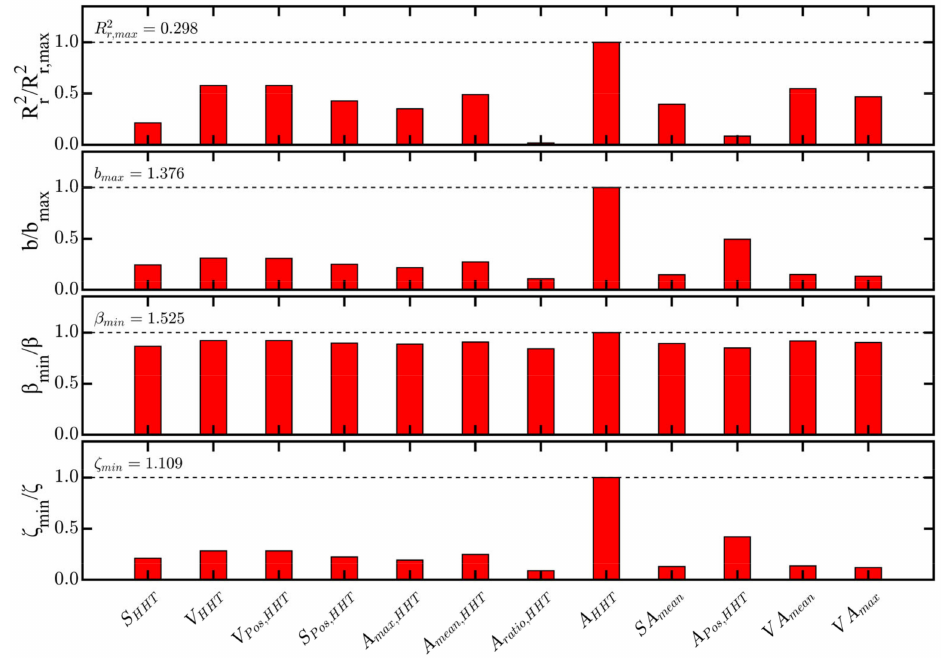
Figure 4. Performance evaluation of the proposed HHT-based IMs in developing